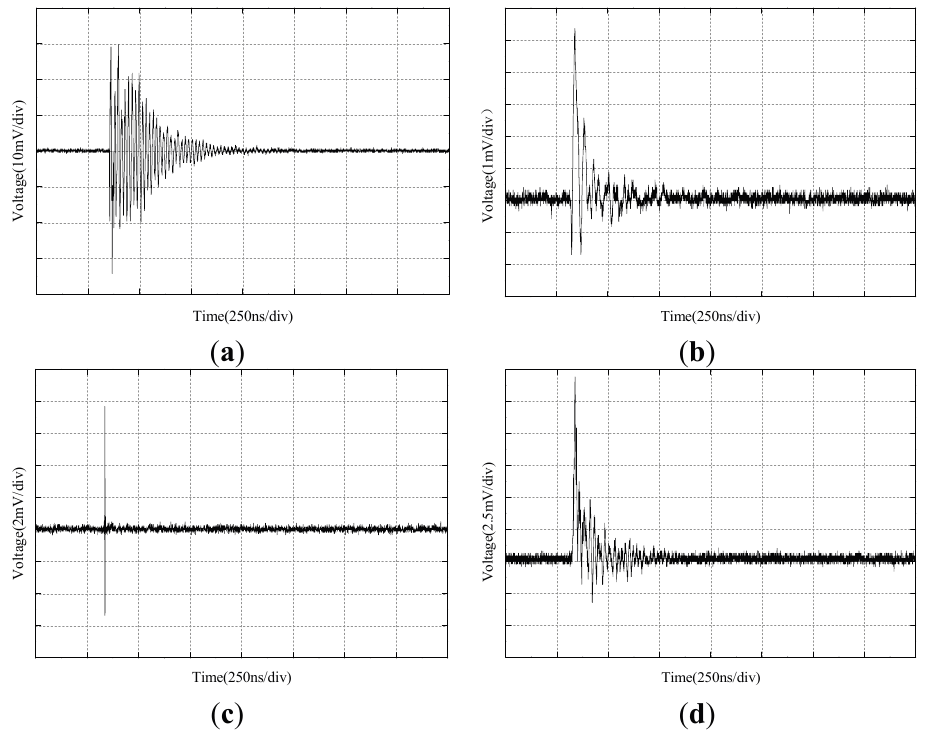
Figure 16. UHF waveforms of the PD comparison experiment: ( a ) ESA; ( b ) MPA; ( c ) MSA; ( d )